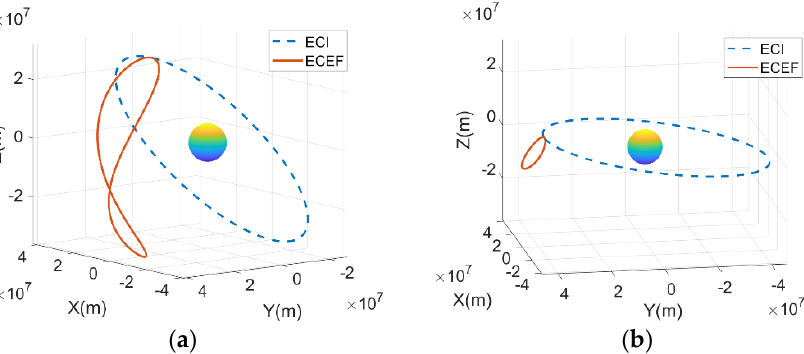
Figure 2. GEO SAR space trajectory. ( a ) “8” shaped orbit; and ( b ) near-circular orbit.